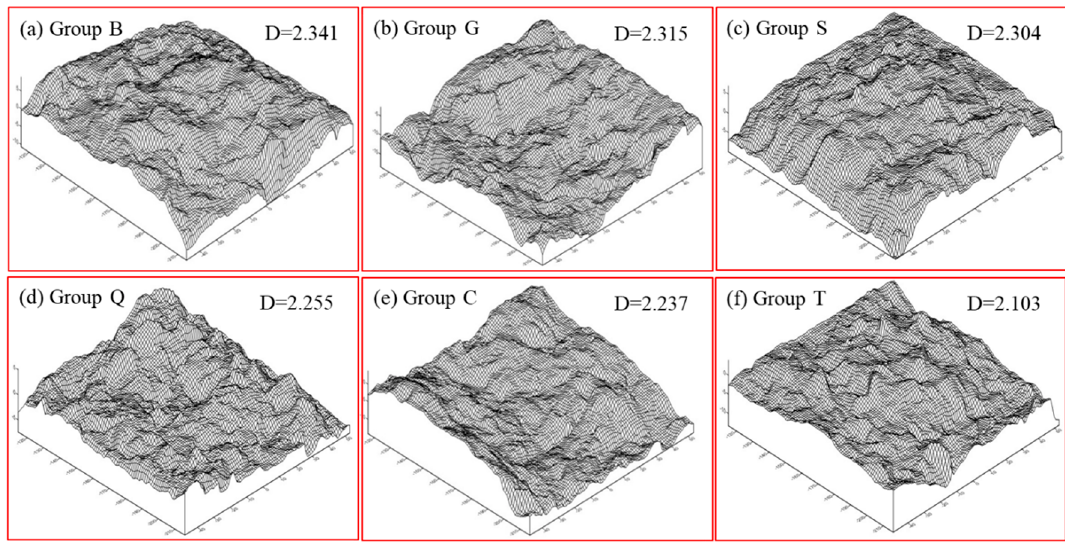
Figure 2. The surface of the new-to-old concrete with different roughness: ( a ) Group B, ( b ) Group G, ( c ) Group S, ( d ) Group Q, ( e ) Group C, ( f ) Group T.